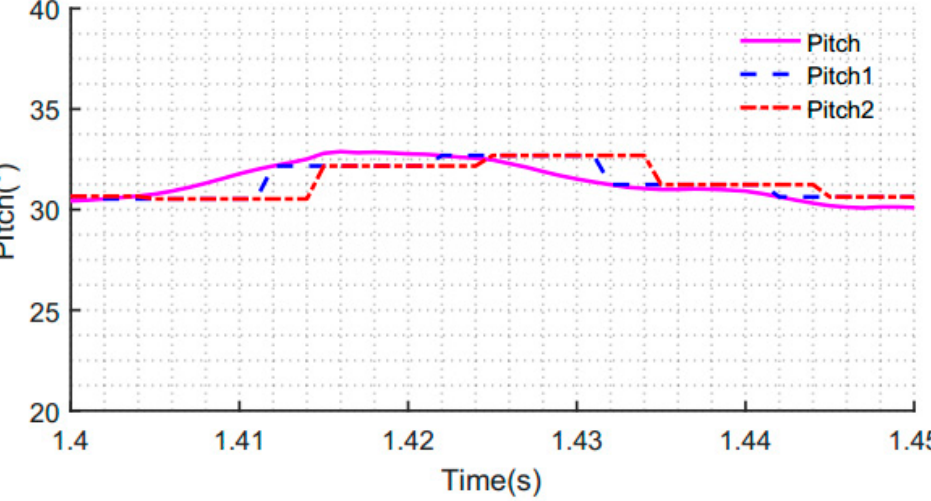
Figure 14. Partially enlarged pitch angle obtained by fusion of the accelerometer and gyroscope data.